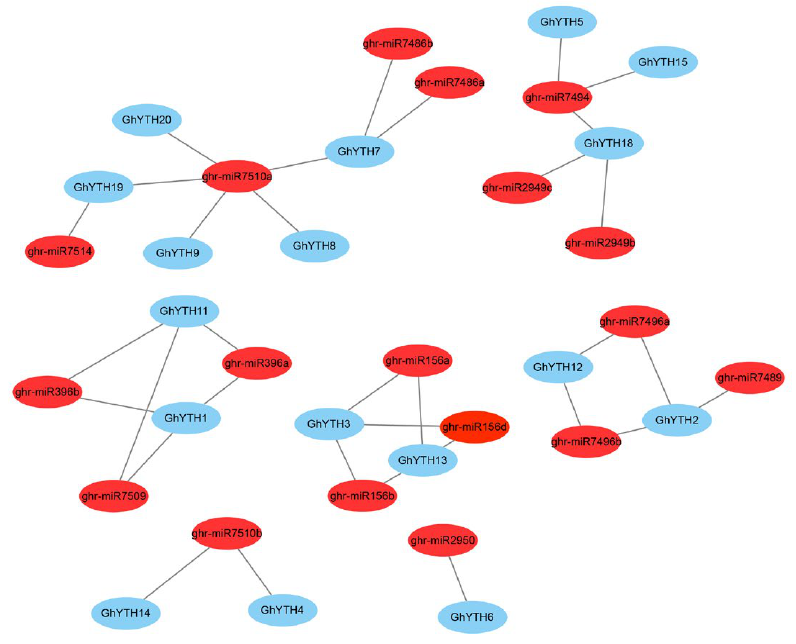
Figure 6. miRNA targets of YTH genes in G. hirsutum . The red circles represent miRNAs. The blue circles indicate GhYTH